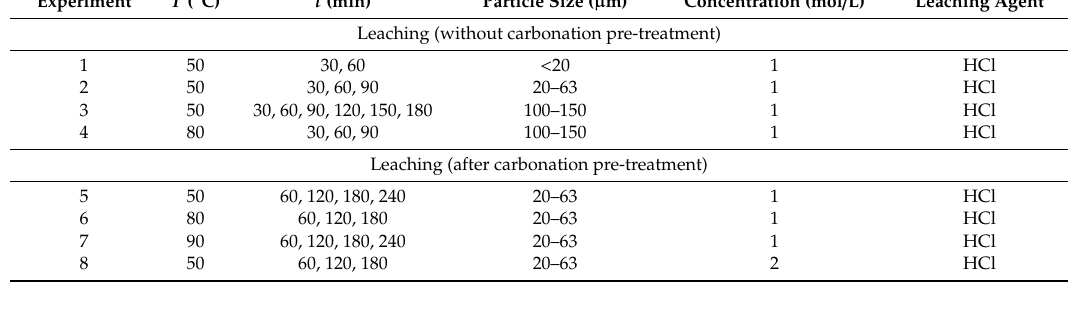
Table 3. Leaching parameters for the executed experiments with and without carbonation pre-treatment.